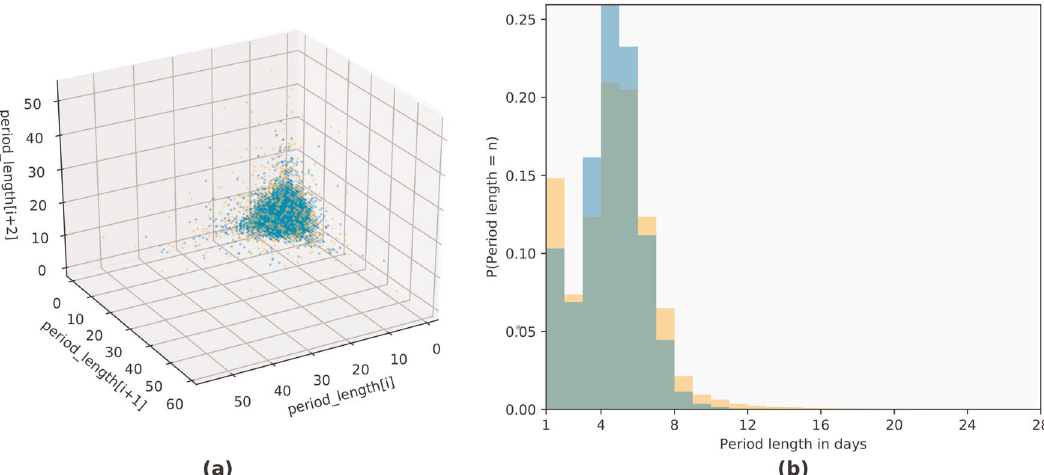
Fig. 4 Time series embedding and probability distribution for period length (all users, across groups). Time series embedding ( a ) and probability distributions ( b ) of period length for the consistently not highly variable (teal) and consistently highly variable (orange) groups. a The period lengths of three consecutive randomly sampled cycles from each user in the cohort are plotted on the x , y , and z axes. Visually, we observe that both groups occupy a very similar region of the period length space (few orange points are placed outside the region occupied by the teal cluster). b The period length probability distributions of the cohort, where we observe that the orange and teal distributions are largely overlapping, with the same median of 4 days and a similar shape, indicating that period lengths are distributed very similarly for the two groups. We notice a slight peak in single day period reports in both groups, which we argue is reminiscent of app usage behavior: some users are interested in knowing (approximately) when they had their period, not in tracking how long it was, so they may only track the day it occurred and not continue tracking after